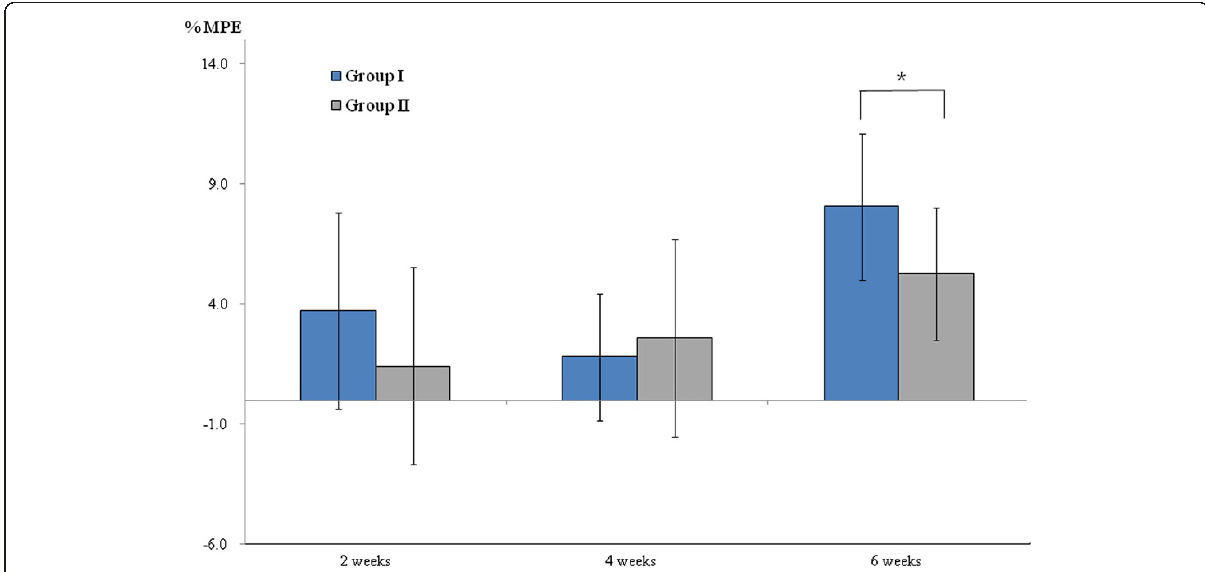
Figure 3 The assessment of thermal thresholds using tail-flick analgesia meter. Effects of green tea extracts on tail flick test after oxaliplatin administration indicated by maximal possible effect (%MPE) (mean±SD), which showed the mean%MPE of Group II with green tea(300 mg/kg orally once daily) were statistically lower than those of Group I without green tea at 6 weeks after oxaliplatin administration ( P <0.05). * P <0.05.